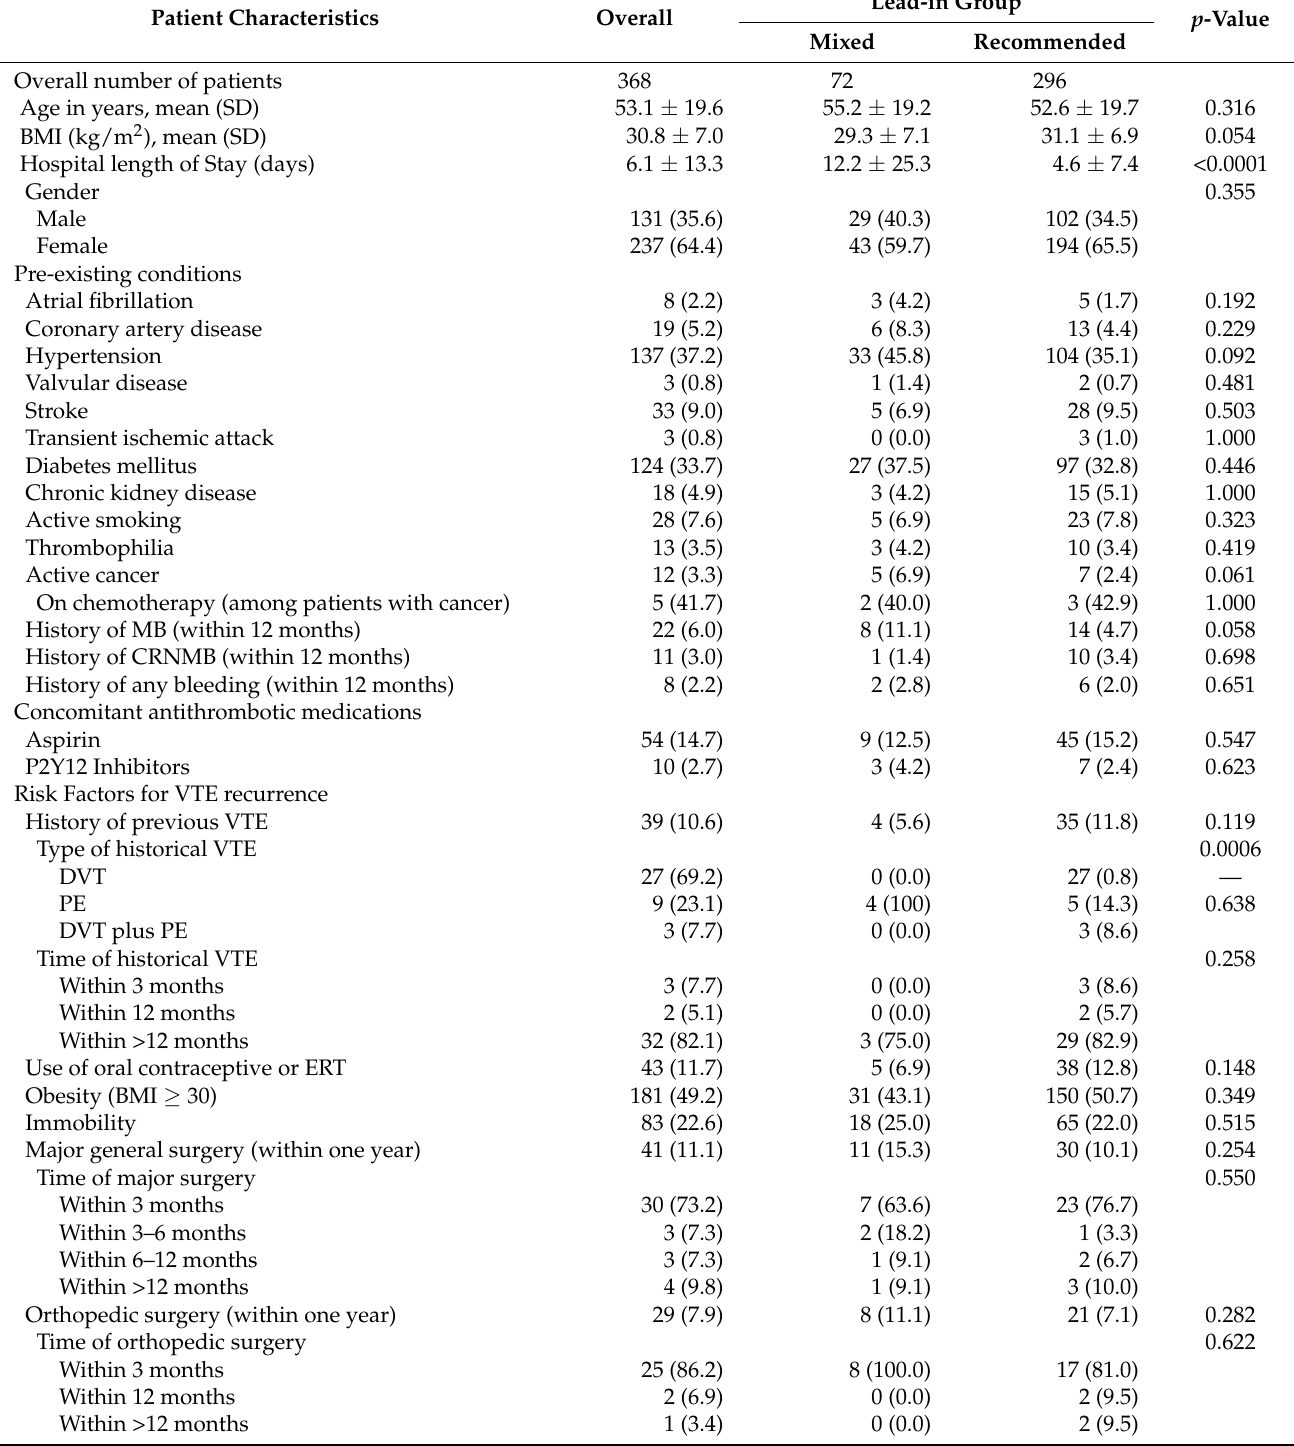
Table 1. Patient demographics, clinical characteristics, and risk factors for VTE